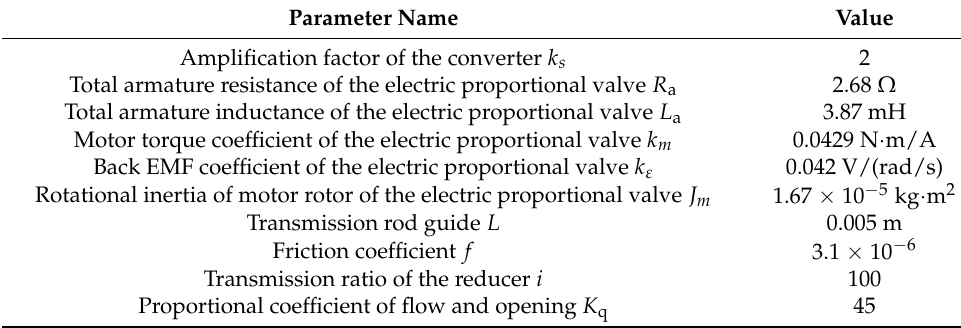
Table 2. Parameters of the control